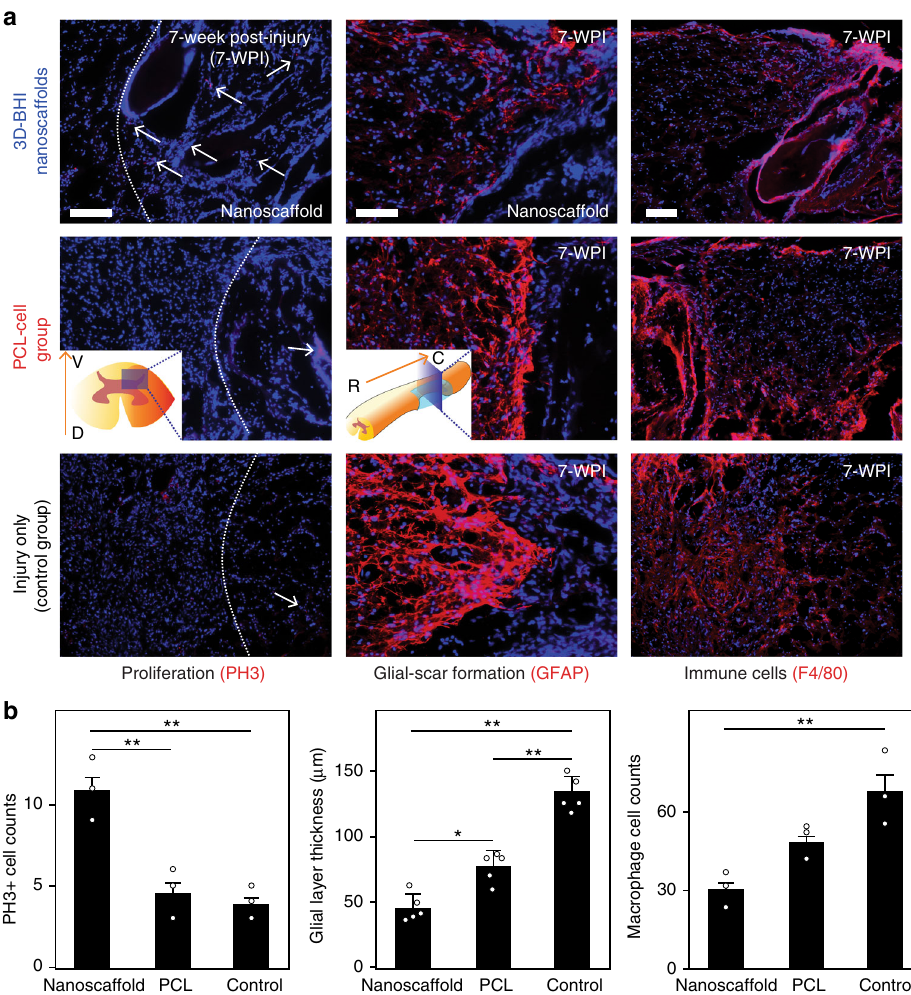
Fig. 8 Improved long-term effects on SCI sites from 3D-BHI enhanced stem cell transplantation. a , b Histological immunostainings images ( a ) and quanti fi cations ( b ) of cell proliferation markers (PH3), astroglial markers (GFAP), and immune cell markers (F4/80). These results collectively suggesting an improved stem cell transplantation from our 3D BHI nanoscaffolds can enhance cell proliferation inside scaffolds, reduce glial-scar formation and decrease in fi ltration of in fl ammatory cells in vivo at 7-WPI. Cell nuclei were colored in blue in a ; other staining (PH3, GFAP, and F4/80) were in red. Scale bars in a : left and middle column: 200 μ m; right column: 100 μ m. Error bars represent mean ± s.d.; n = 3 or 5, * P < 0.05, ** P < 0.01 by one-way